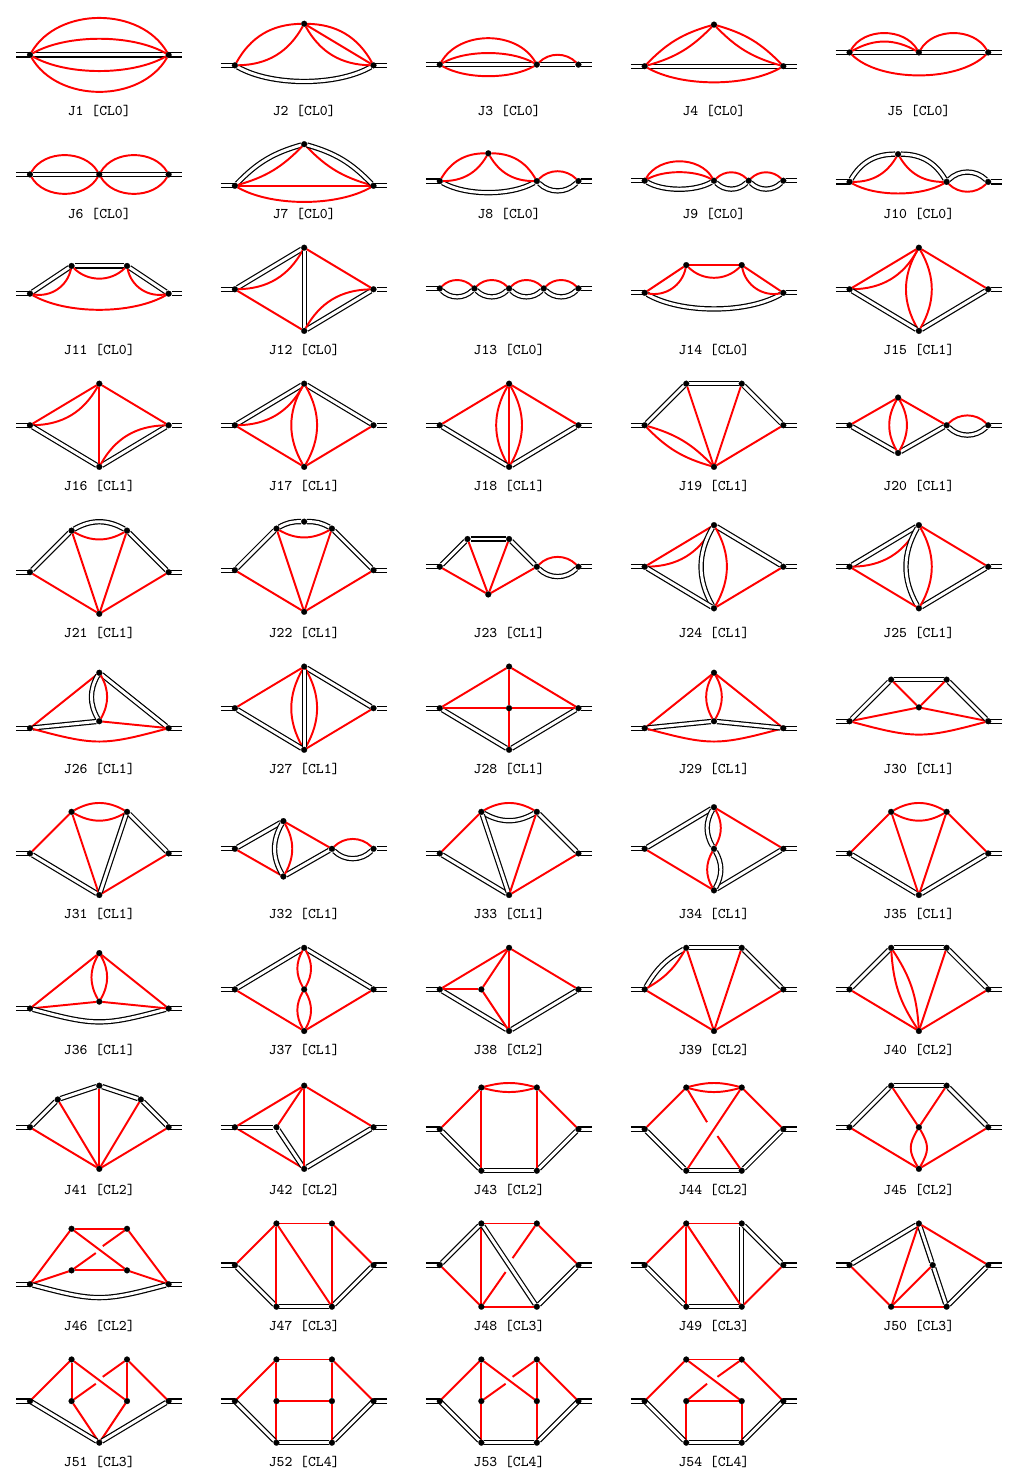
Figure 1 . Four-loop propagator-type HQET integrals calculated in this paper. Red solid lines correspond to massless propagators [ − l 2 − i 0] − 1 , double lines correspond to the HQET propagator [1 − 2 l · n − i 0] − 1 , (where n 2 = 1 ). The loop integration measure is d d l iπ d/ 2